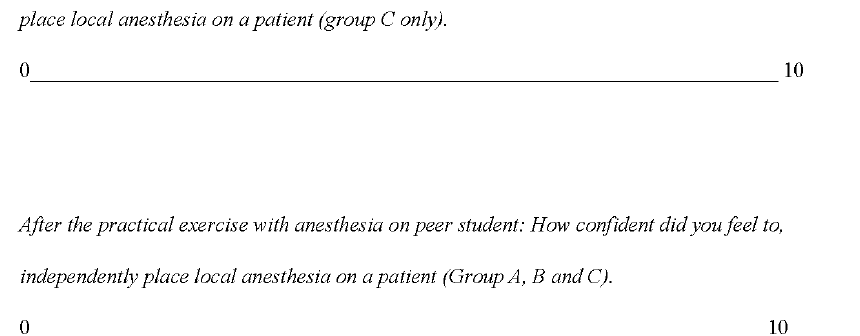
Figure A1. Questionnaire.